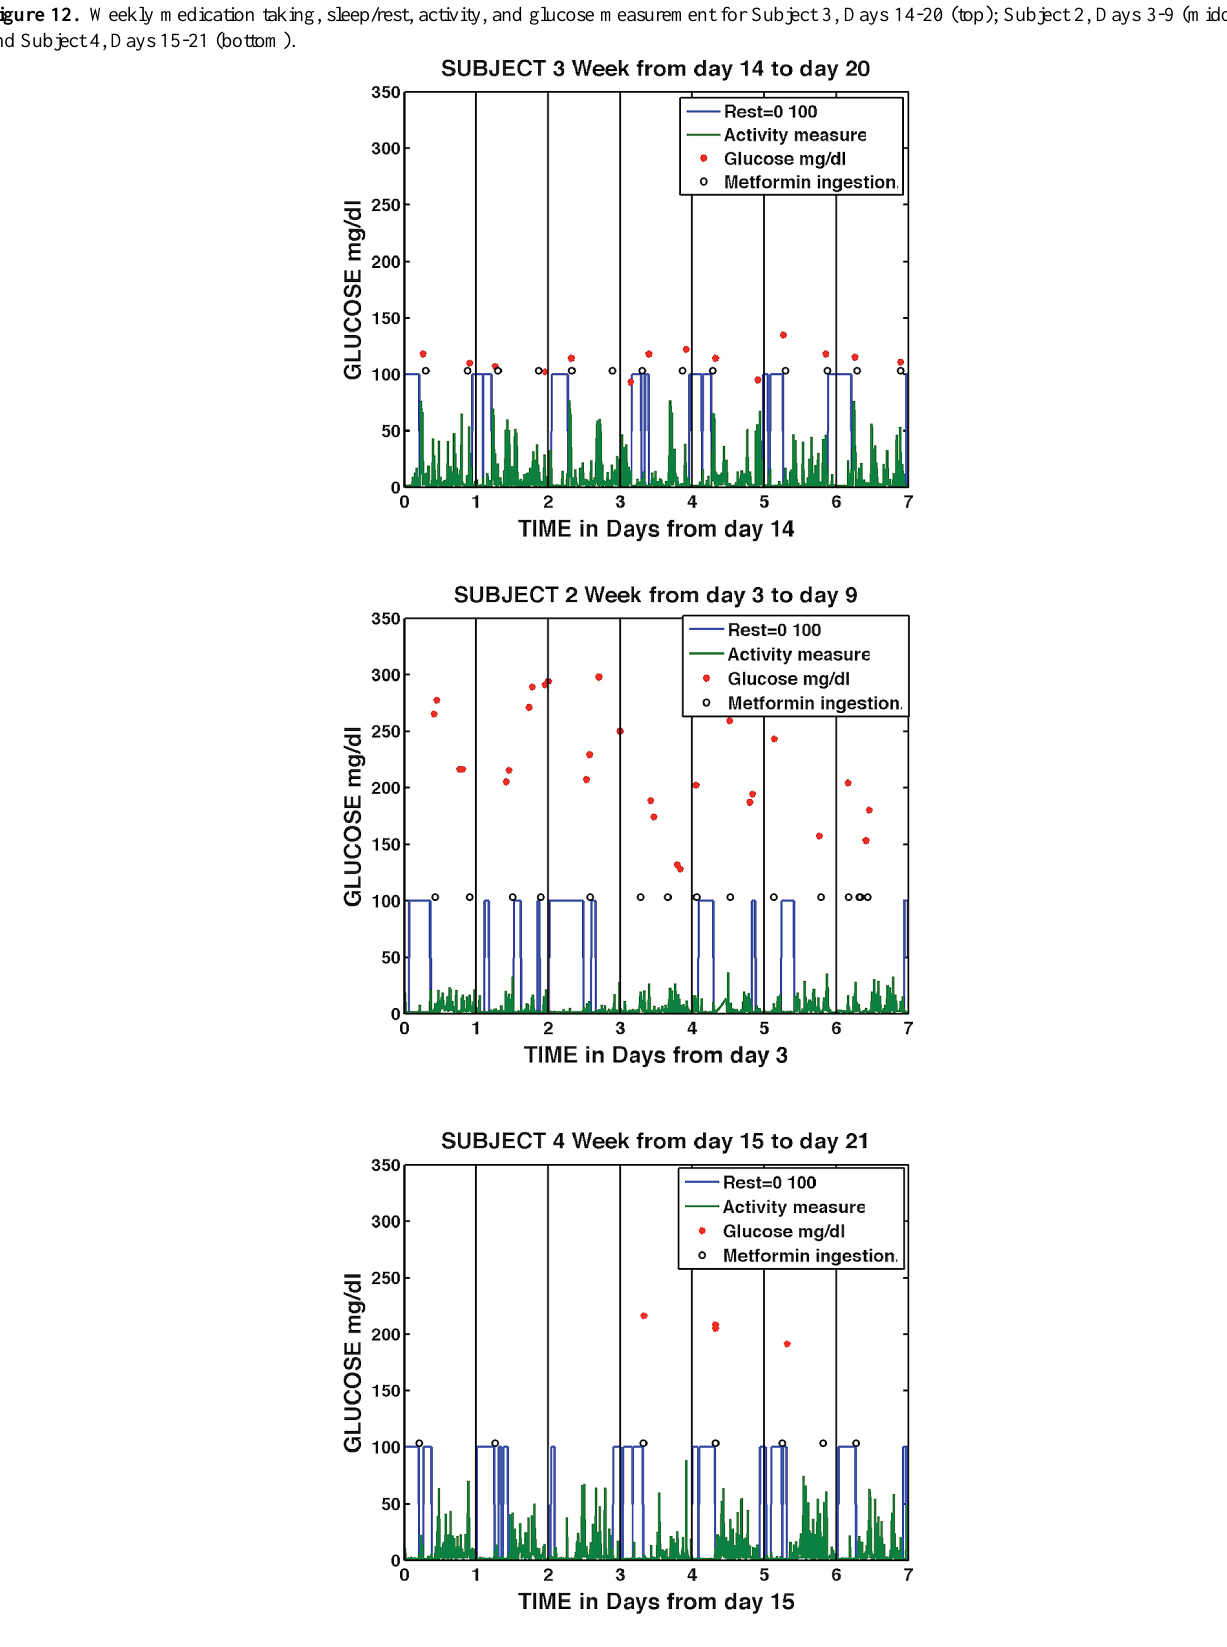
Figure 12. Weekly medication taking, sleep/rest, activity, and glucose measurement for Subject 3, Days 14-20 (top); Subject 2, Days 3-9 (middle); and Subject 4, Days 15-21